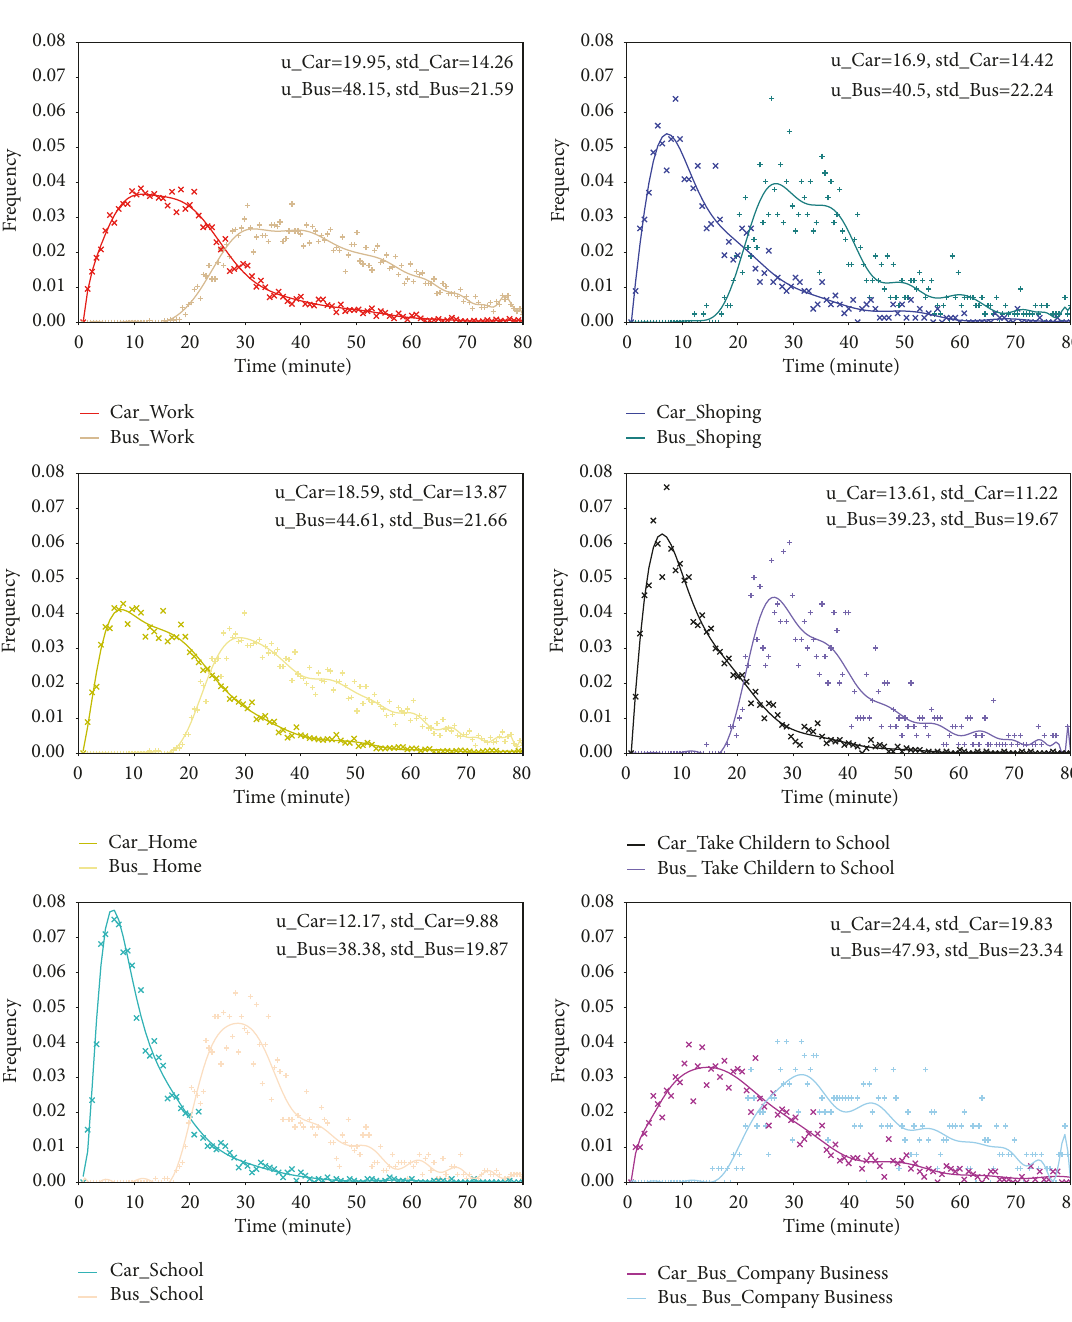
Figure 12: Car and bus travel time distribution with different